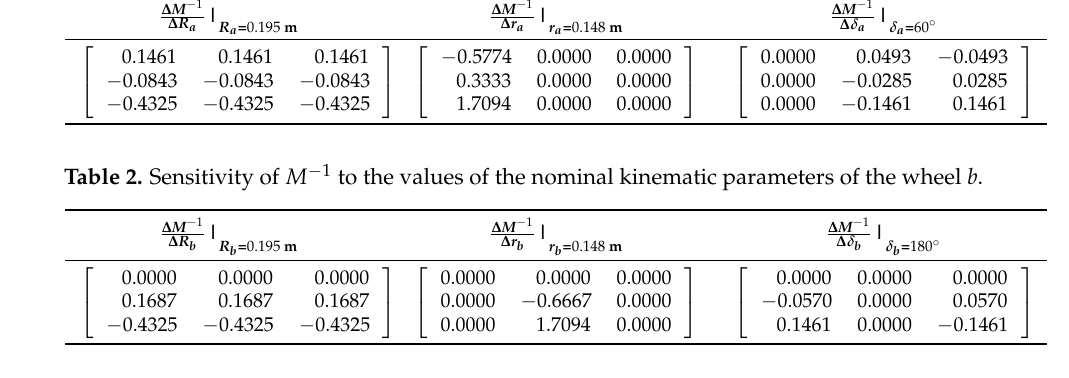
Table 3. Sensitivity of M − 1 to the values of the nominal kinematic parameters of the wheel c